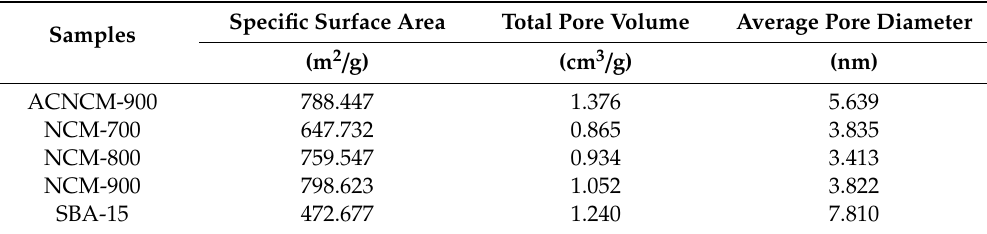
Figure 5. ( a ) Small angle XRD patterns of ACNCM-900, NCMs, and SBA-15; ( b ) wide angle XRD pattern of NCM-900; ( c ) nitrogen adsorption–desorption isotherms, and ( d ) pore size distribution curves of ACNCM-900, NCMs, and SBA-15. Table 2. The results of nitrogen adsorption and desorption